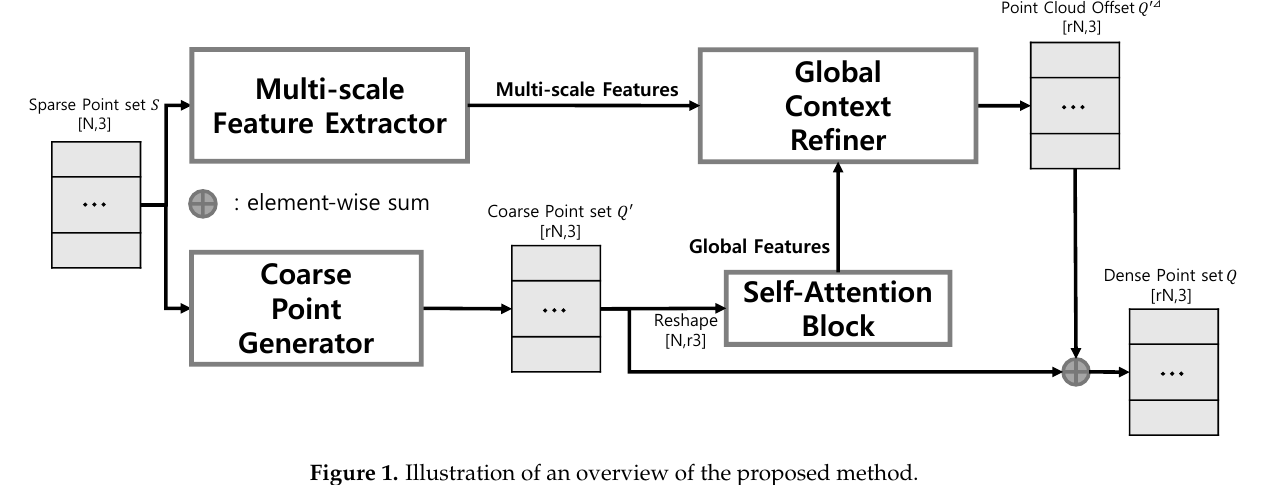
Figure 1. Illustration of an overview of the proposed method.